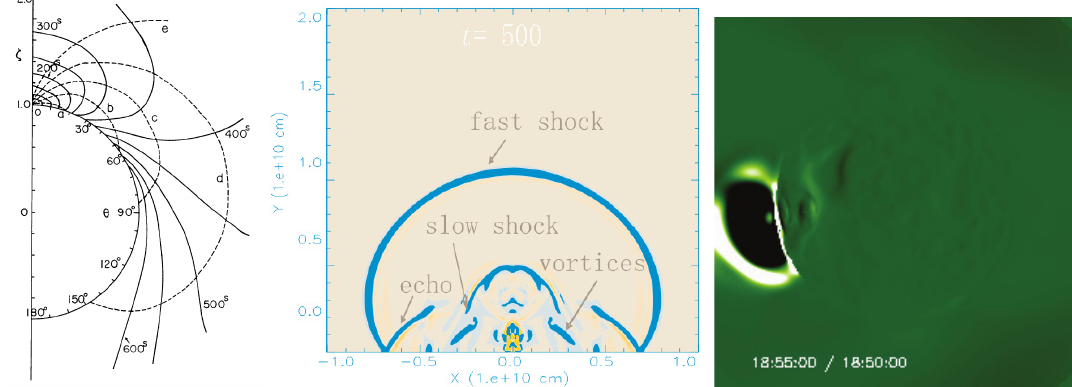
Figure 41: Three generations of numerical MHD wave models. Left : the original coronal fast-mode MHD wave model, a 2D model based on linearized MHD equations. Solid lines represent the dome-shaped coronal wavefronts, dashed lines the paths of wave packets. Middle : 2D, time-dependent, ideal MHD model of an erupting flux rope. The eruption generates a fast-mode shock wave, and in addition, slow-mode shocks, echoes and velocity vortices are formed in the wake of the fast shock. Right : 3D thermodynamic MHD simulation. The panels shows a synthetic 195 ˚A image generated from the model. Images reproduced with permission from [left] Uchida (1968), copyright by Springer; [middle] Wang et al. (2009) and [right] Downs et al. (2011), copyright by